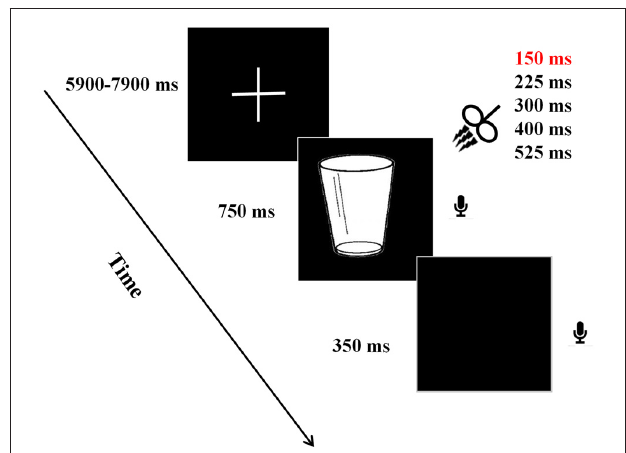
FIGURE 1 | Experimental paradigm. A new trial began with a fixation cross presented between 5900 ms and 7900 ms. Thereafter, a target picture was presented for 750 ms, followed by a blank screen for 350 ms. During the presentation of picture, triple pulse transcranial magnetic stimulation (TMS) stimulation was applied at one of the five time windows in a random way. Participants were instructed to name the presented picture as quickly as possible using a microphone placed in front of each participant. After a jittered delay between 6 s and 8 s, the next trial